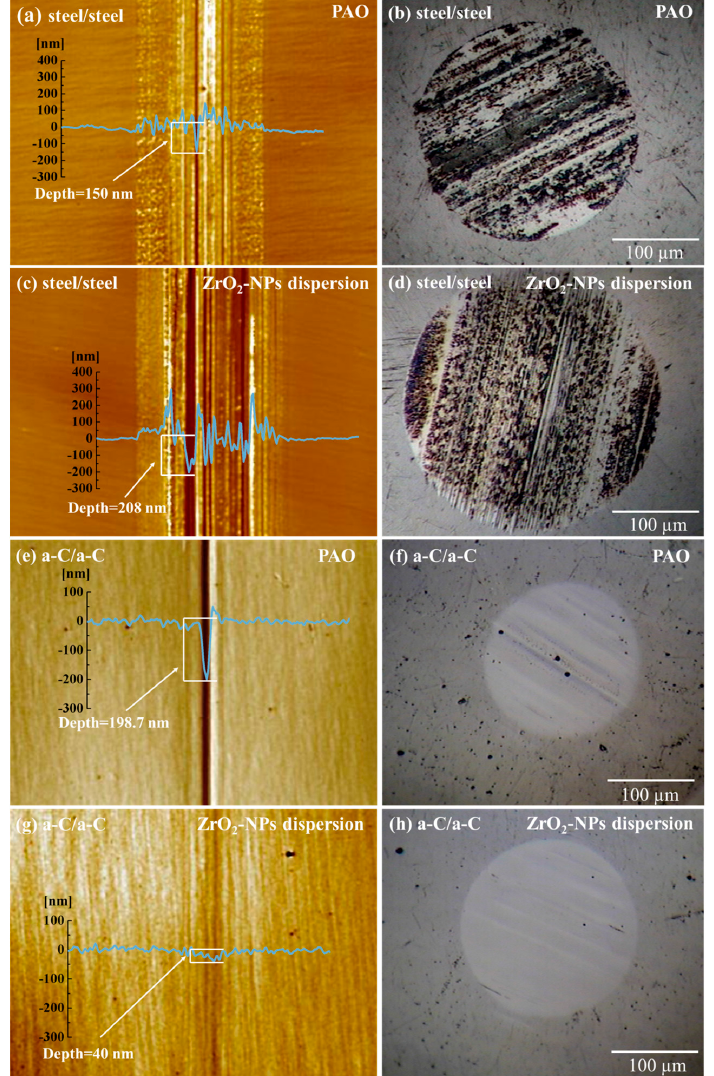
Figure 3. The morphology and cross-sectional profile of the wear tracks on: ( a , c ) steel; and ( e , g ) a-C disks. The optical micrographs of the wear scar on: ( b , d ) steel balls; and ( f , h ) a-C coated balls.